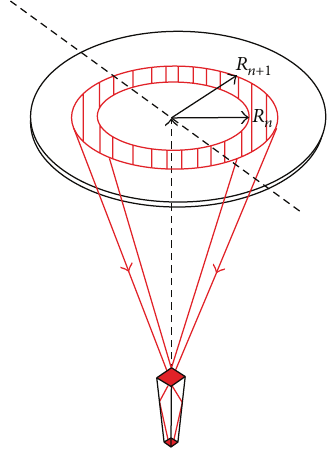
Figure 9: Ray tracing scheme of incident light ring of variable radius.